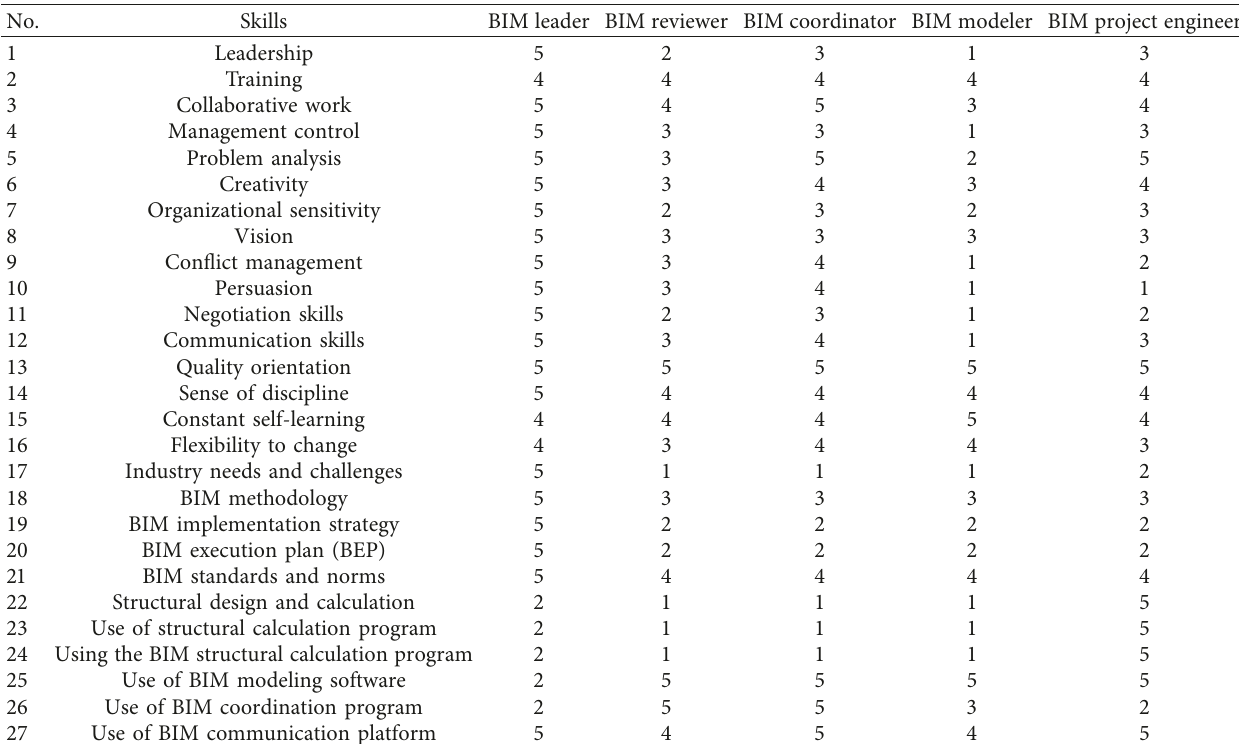
Table 4: Competencies and capacities a professional must have to assume a certain BIM